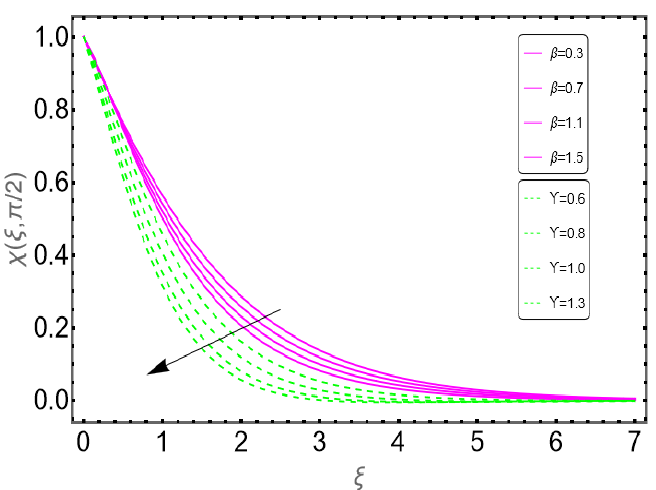
Figure 15. Profile of φ for Sc and δ 2 . Figure 15. Pro fi le of Figure 15. Pro fi le of